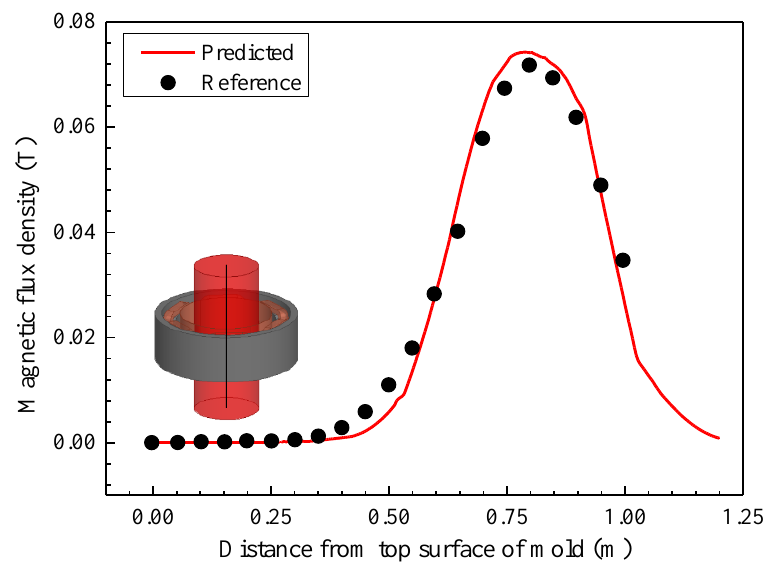
Figure 2. Comparison of the magnetic flux density along the axis of the stirrer using the data in reference [30]. Reprinted with permission from [30]. Copyright 2021 Acta Metallurgica Sinica.